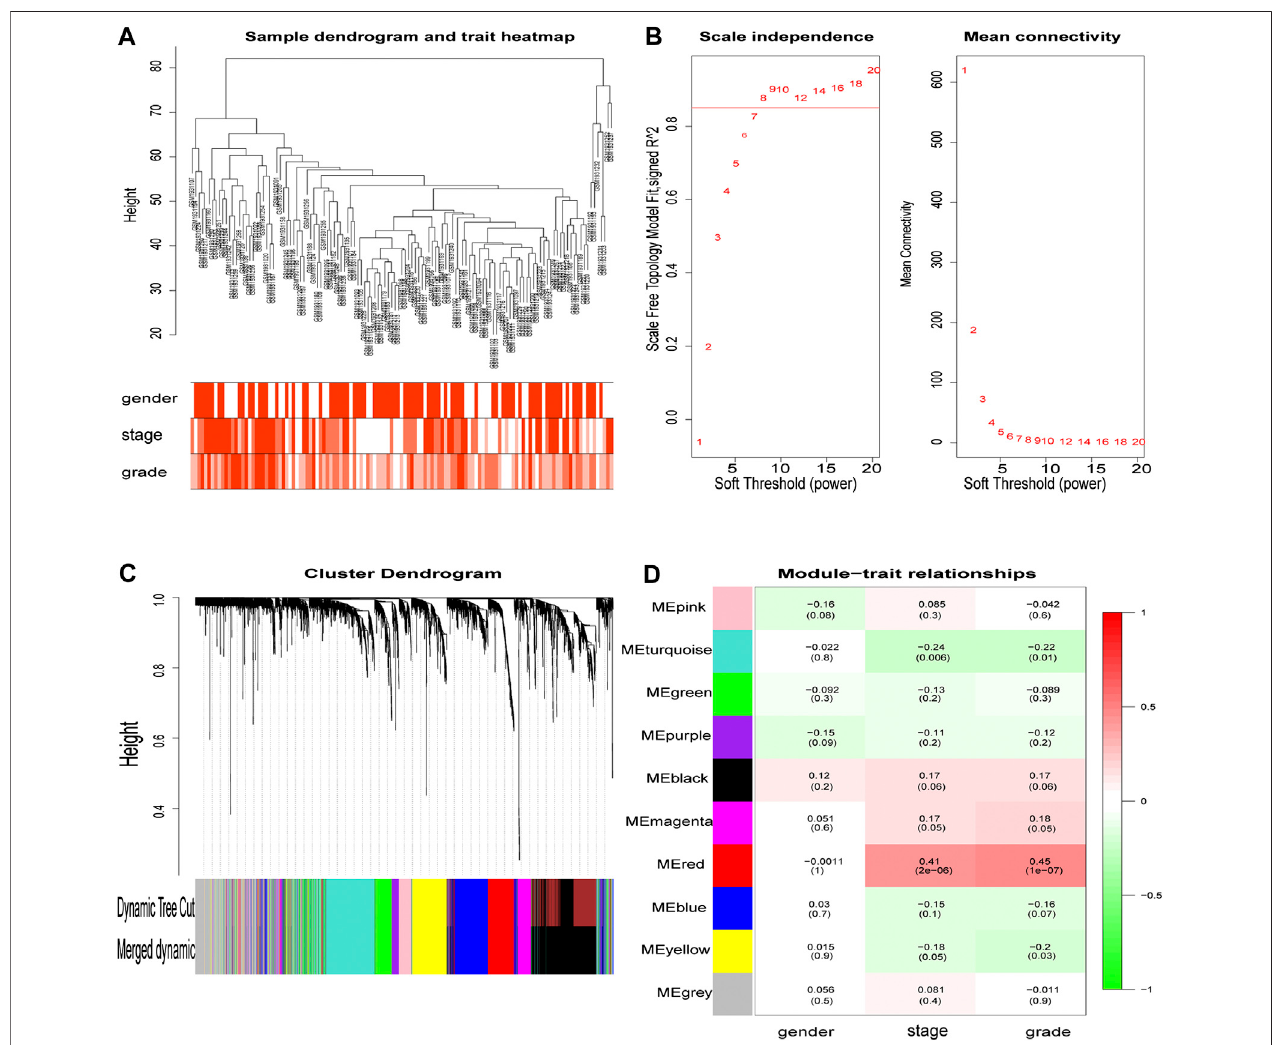
FIGURE 3 | The main steps of WGCNA. Clustering dendrogram of tumor samples with its clinical information. Determination of soft threshold and examination of the scale free topology ( β (cid:1) 8). Hierarchical clustering dendrogram of module eigengenes. Correlation between module and clinical feature, red represents the positive correlation and green represents the negative correlation. The depth of color represents the value of the